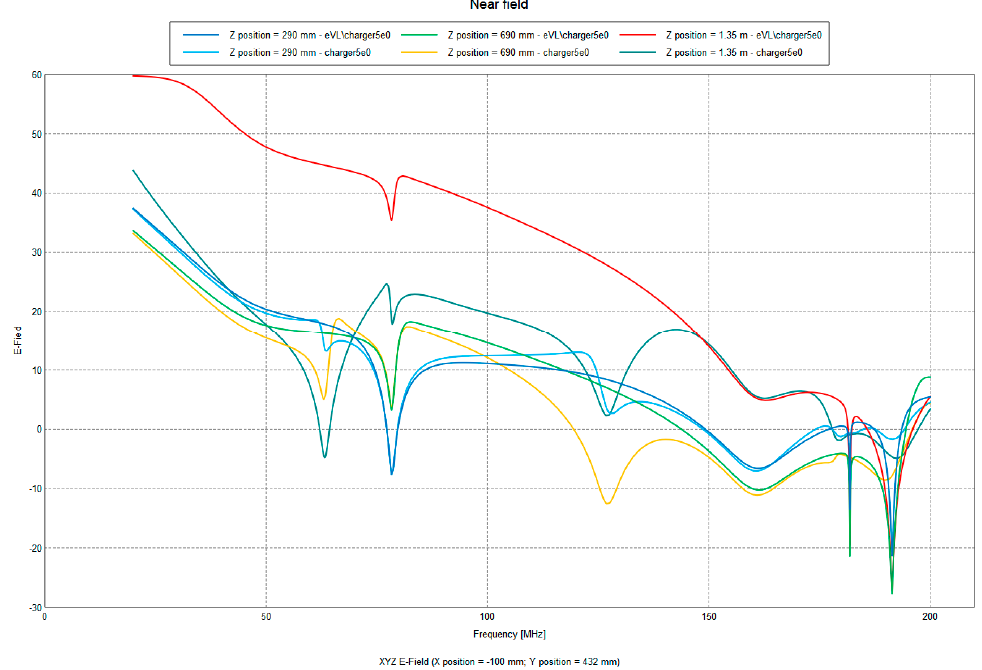
Figure 8. E-field shielding effectiveness (dB) for two different cabinet layouts (lower door only and both doors) and for three axial positions at 10 cm inside the cabinet (vertical plane polarization).